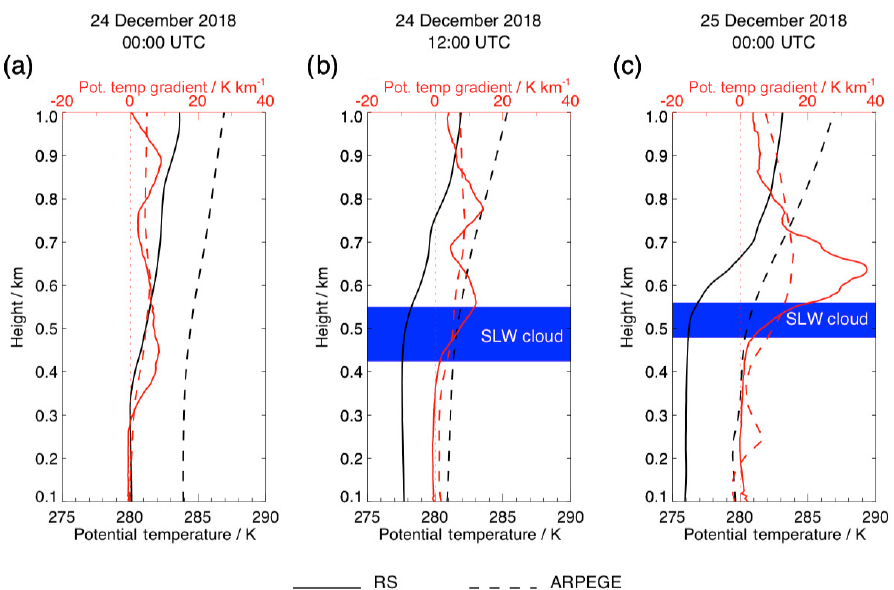
Figure 8. Vertical profiles of potential temperature θ (black) and the gradient in potential temperature ∂θ/∂z (red) as calculated from temperature measured by the radiosondes (solid line) and analysed by ARPEGE-SH (dashed line) at Dome C on 24 December 2018 at (a) 00:00 and (b) 12:00UTC and (c) on 25 December 2018 at 00:00UTC. The presence and the depth of the SLW cloud detected from lidar observations are indicated by a blue